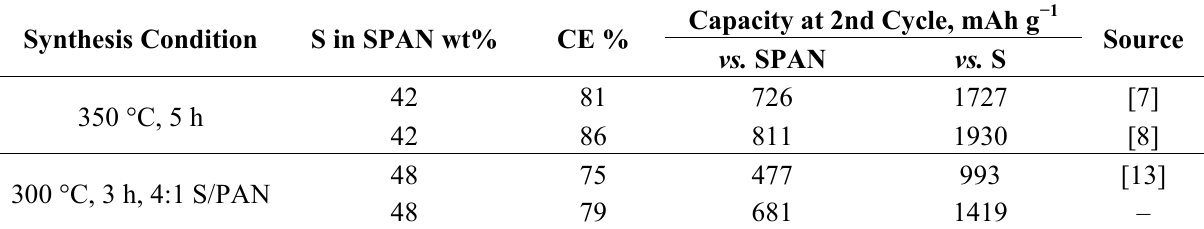
Table 2. Correlation of reversible capacity in 2nd cycle and initial coulombic efficiency